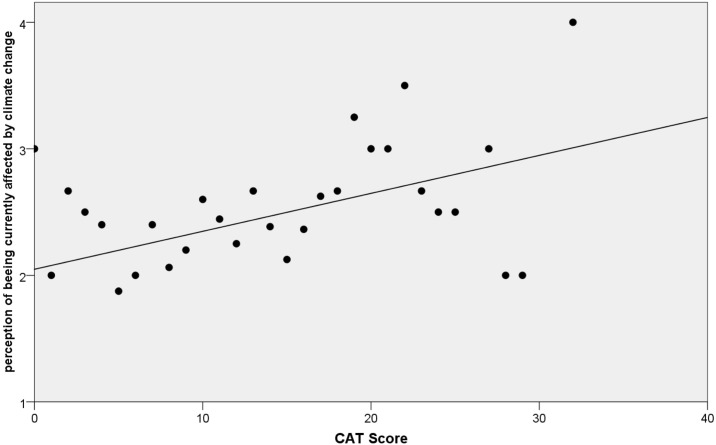
Correlation between CAT score and perception of being currently affected by climate change (p<0.01, r = 0.222 by Spearman's Rank-Order Correlation).